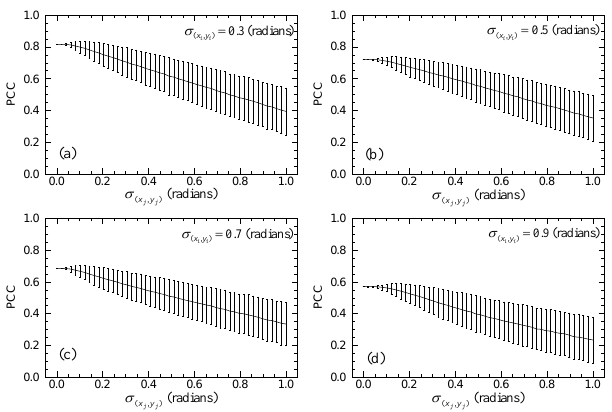
Figure 1. The variation of PCCs represented as SDs in the simulated phase data at the two adjacent pixels. The solid curves depict the mean values of PCCs, while the error bars denote the SDs of